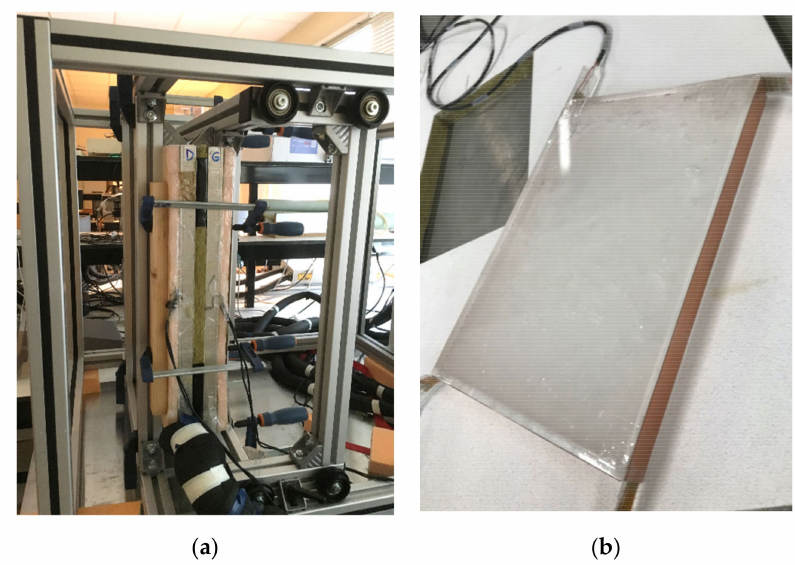
Figure 13. Fluxmetric bench “LGCgE” ( a ), parallelepipedal poly (methyl methacrylate) (PMMA) sample containing PCM with the lateral heat fluxmeters before installation in the insulation ( b ).